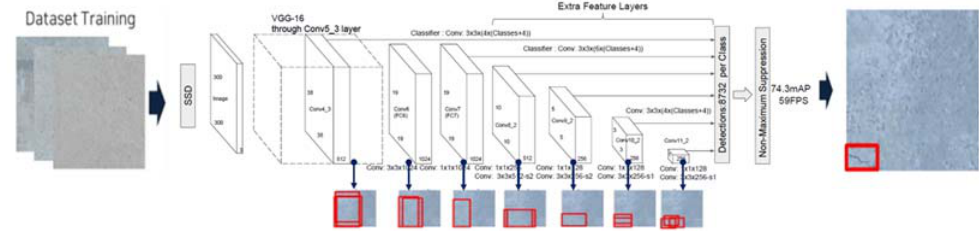
Figure 9. SSD Algorithm Structure and Principle of Operation.